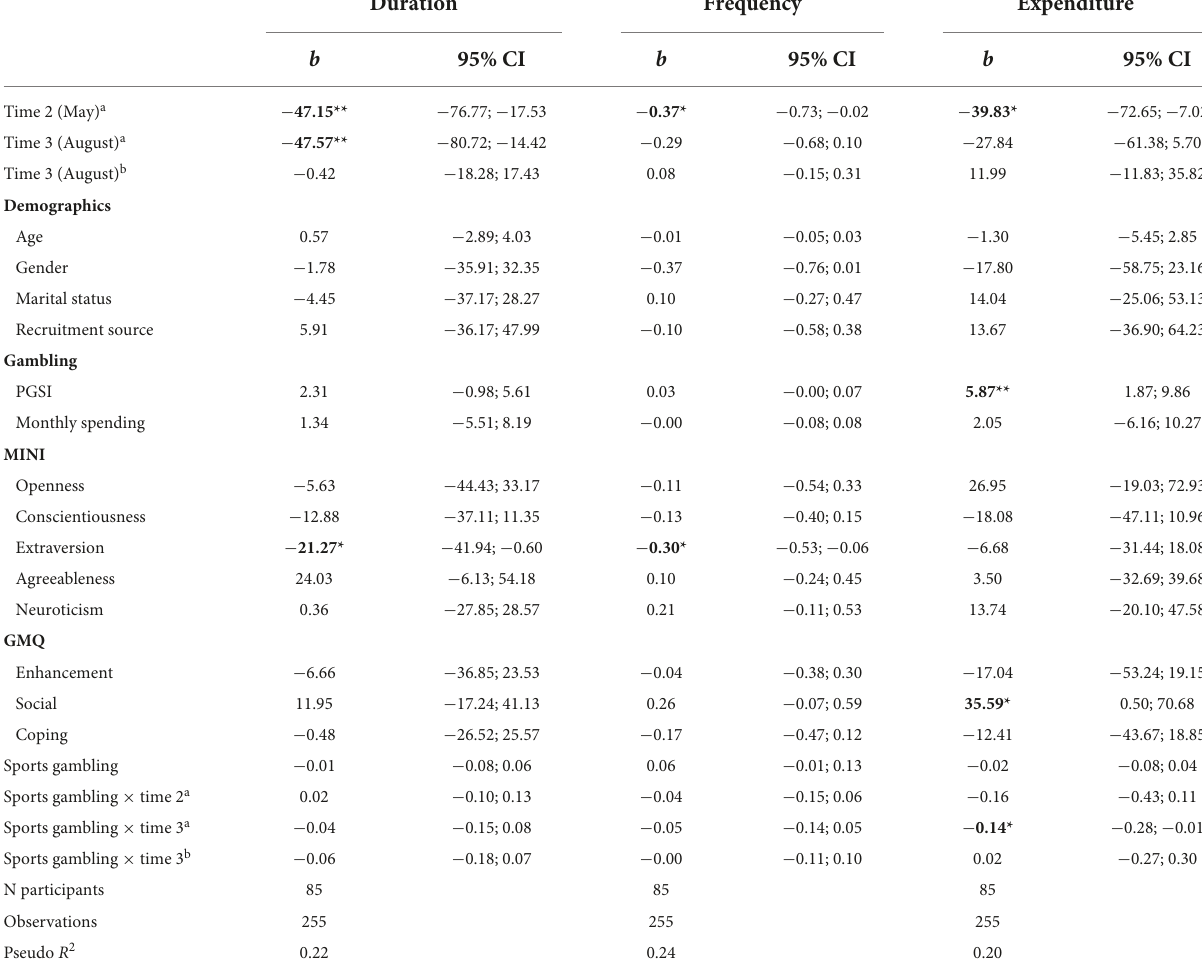
TABLE 4 Linear mixed-model results for non-sports gambling